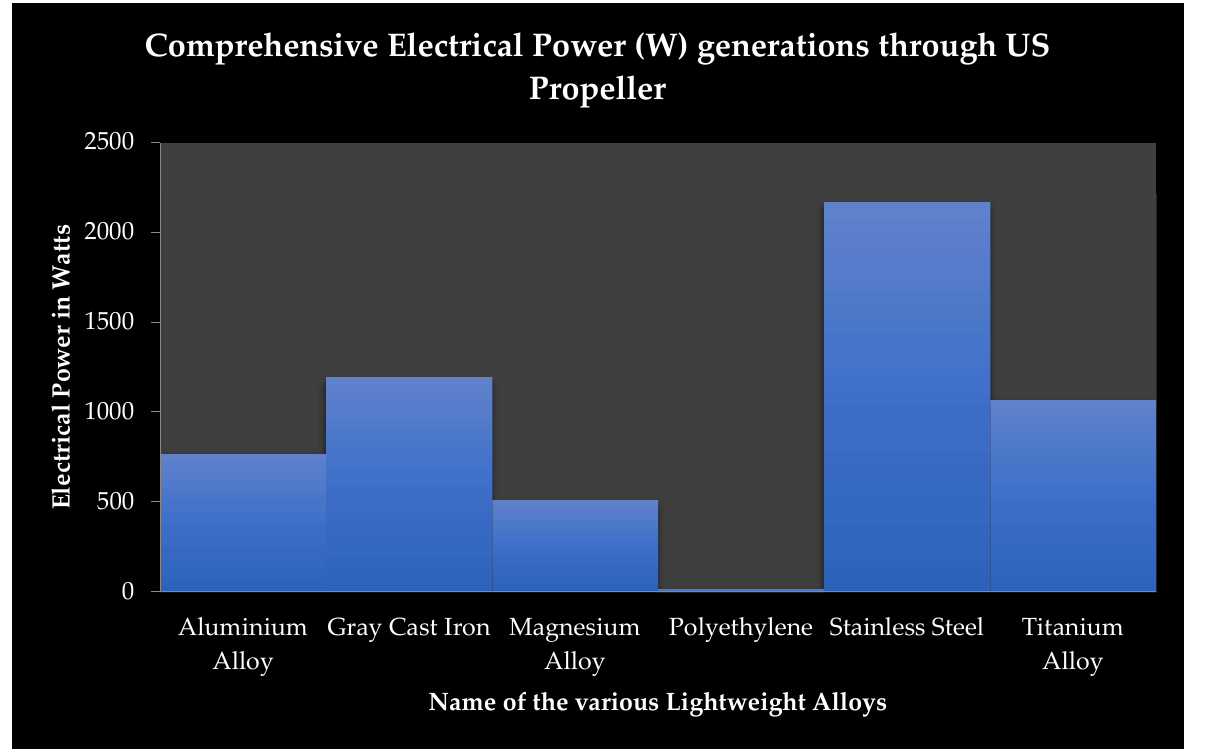
Figure 53. Comprehensive Electricity generation level of various best lightweight alloys.